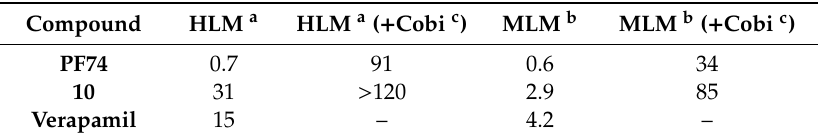
Table 4. Phase I metabolic stability in liver microsomes t 1 / 2